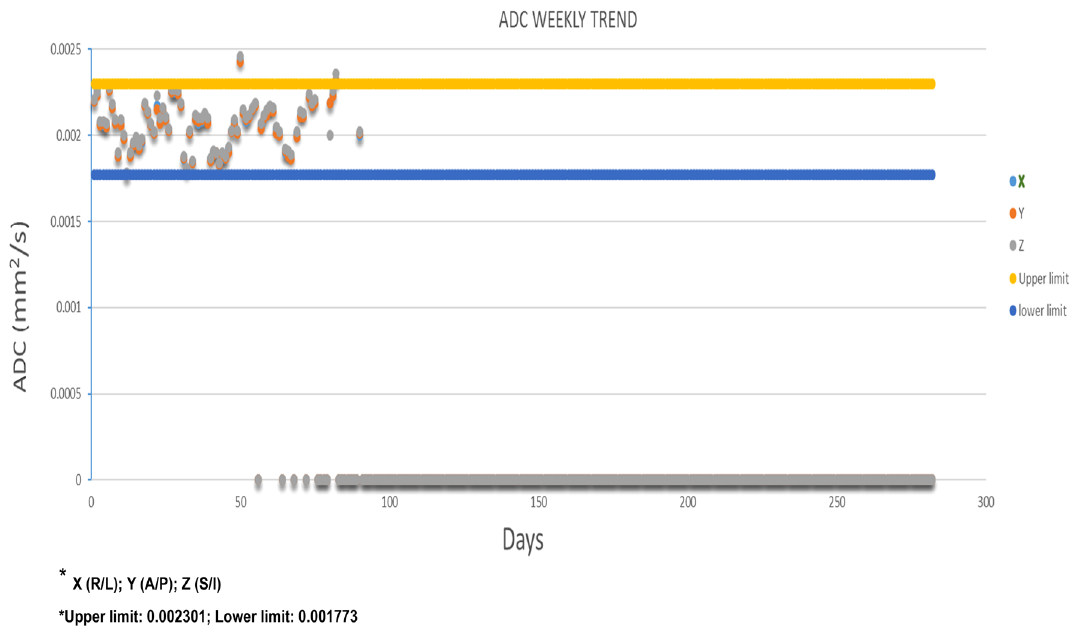
Fig. 6 Apparent diffusion coefficient weekly trends for 2018